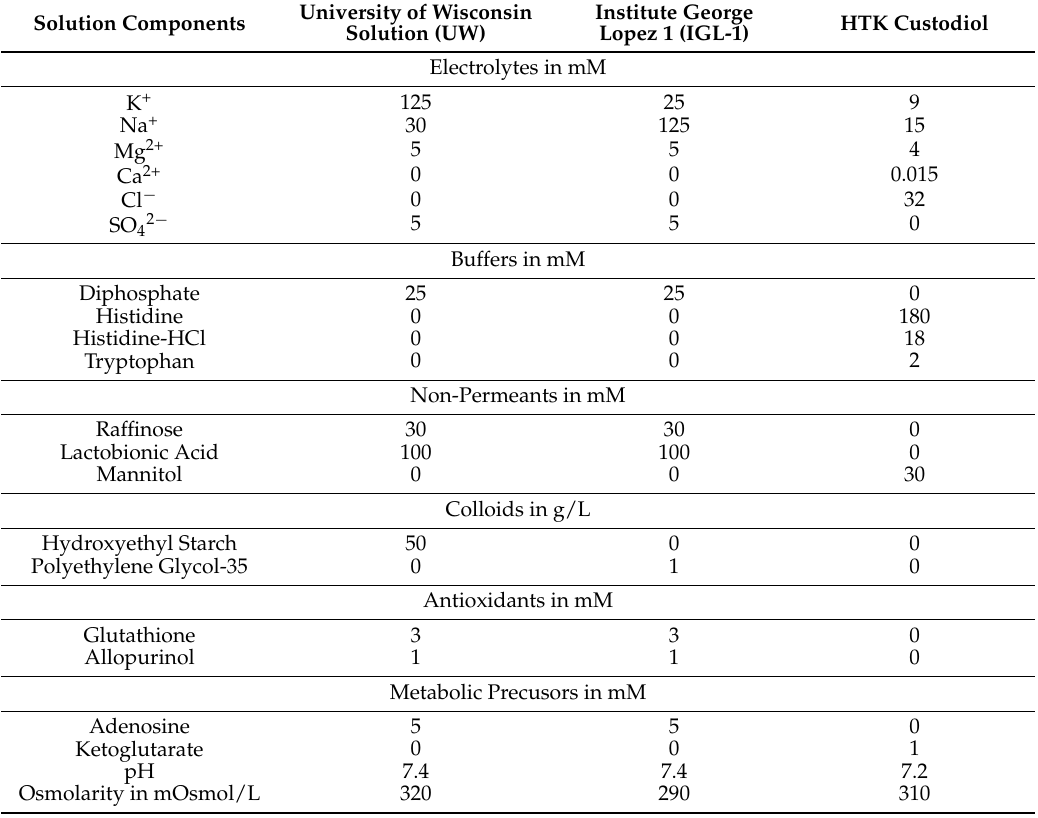
Table 1. Chemical composition of liver graft preservation